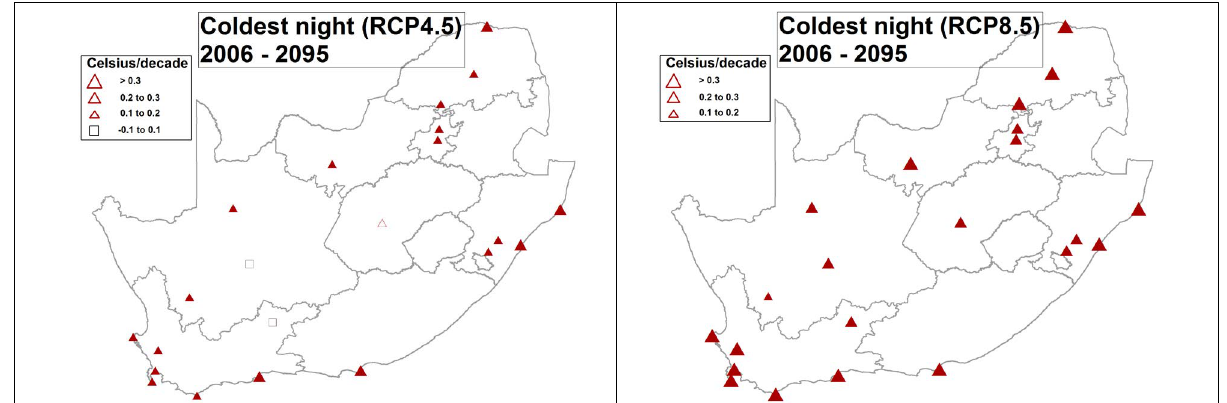
Figure 8: Trends in coldest nights (TNN) in °C per decade, for the period 2006–2095 for the RCP4.5 and RCP8.5 scenarios. Filled triangles denote significant trends at the 5% level.